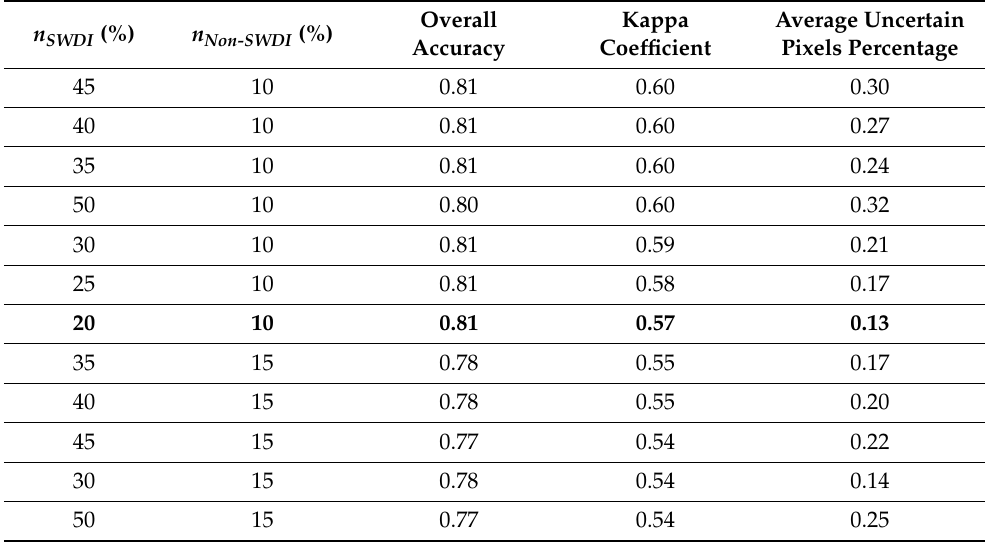
Table 1. SWDI detection candidate sets of thresholds and three validation metrics. The row in bold font indicates the optimal set of